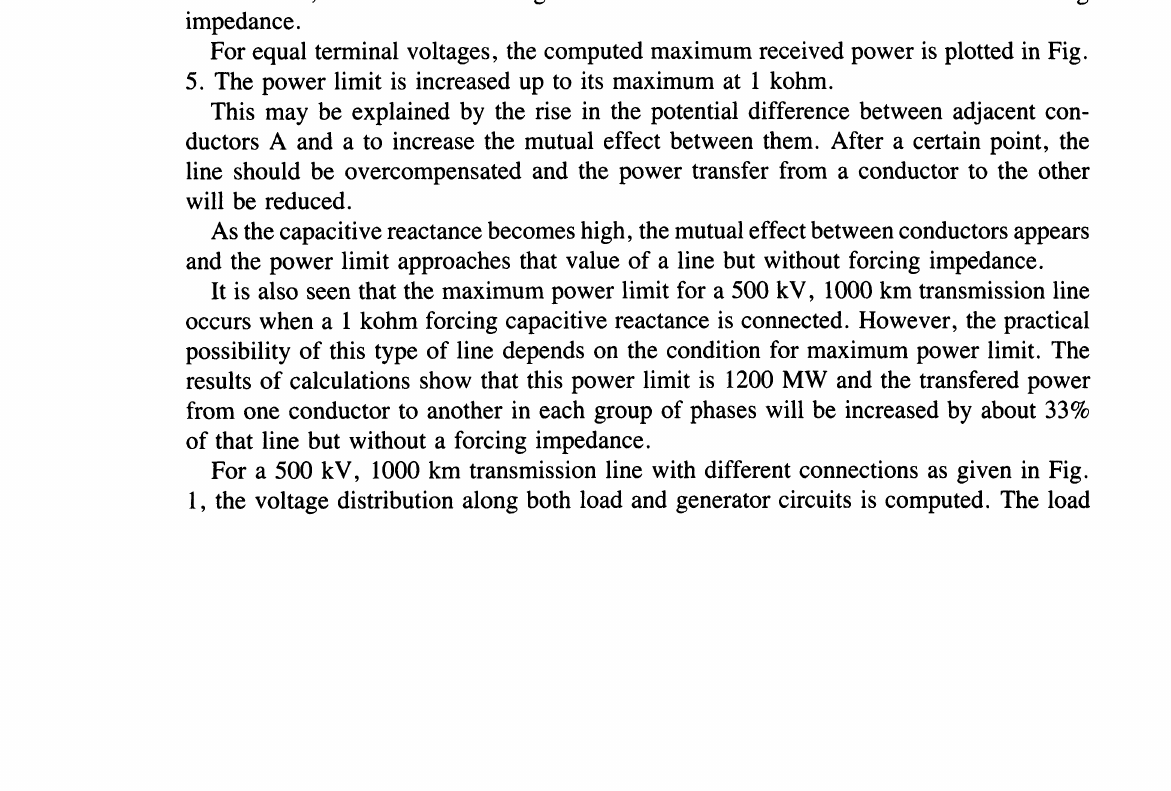
FIGURE 5 The effect of capacitive reactance on power limit and on general constants of a line with separate coaxial phases (connection of Fig. 2c) for the single line of Fig.